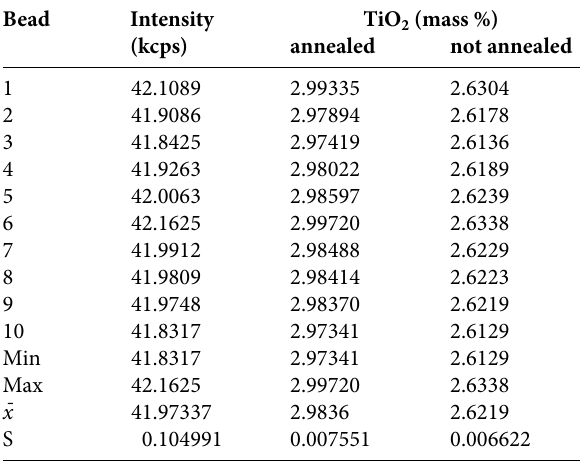
Table 5. The content of TiO 2 in ten different beads of the “Grčka” bauxite sample calculated using the XRF method (by fusion) Bead Intensity